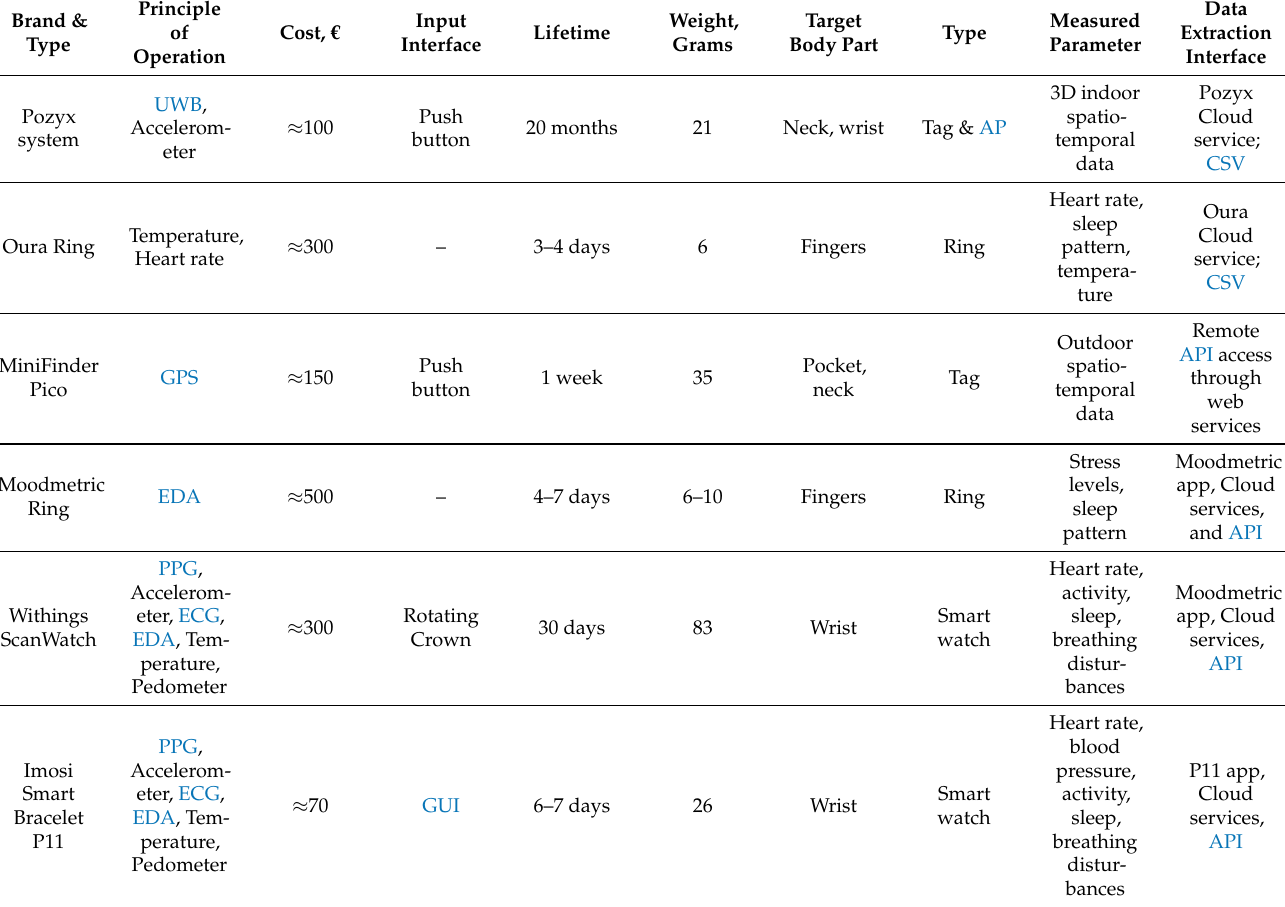
Table 3. Examples of wearable devices for measuring loneliness-related